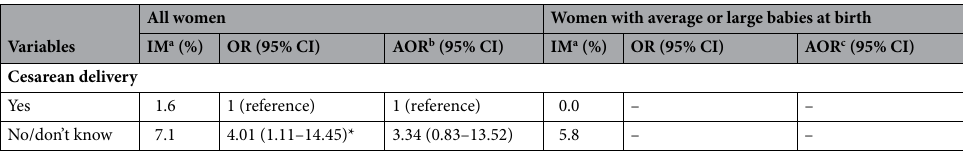
Table 2. Comparison of obstetrical factors according to infant mortality. IM infant mortality, OR odds ratio, AOR adjusted odds ratio, CI confidence interval. *P < 0.05. **P < 0.01. ***P < 0.001. a Sampling weights were applied. b Adjusted for all variables included in Tables 1, 2, 3. c Adjusted for all variables included in Tables 1, 2, 3 except cesarean delivery.